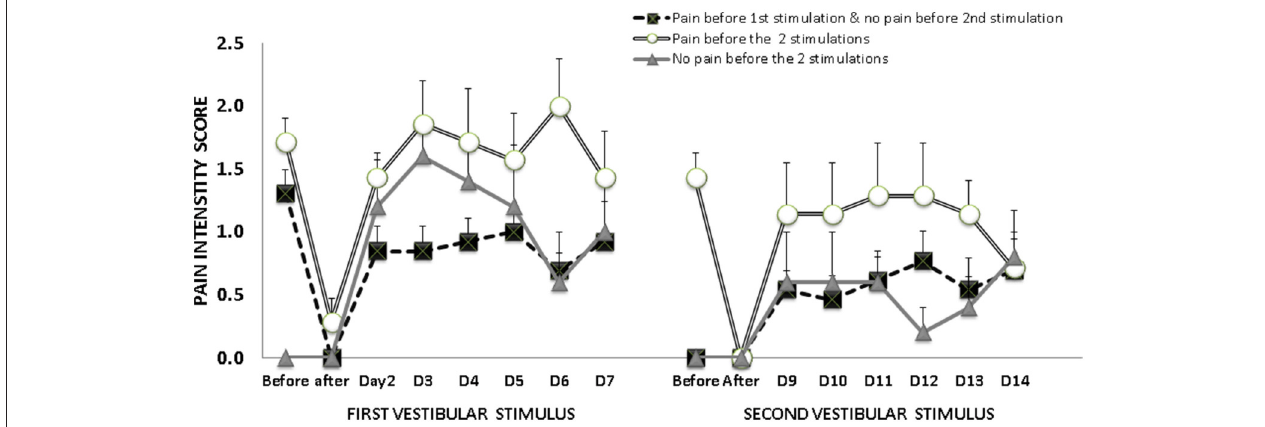
FIGURE 2 | Mean and standard error of the mean of pain intensity scores, before and after vestibular stimulation, according to the report of phantom pain at the moment of each vestibular stimulation 13 patients reported phantom pain just before the first vestibular stimulation, but no phantom pain before the second stimulation; while 7 patients reported phantom pain before the 2 stimulations and 5 patients reported no phantom pain before either